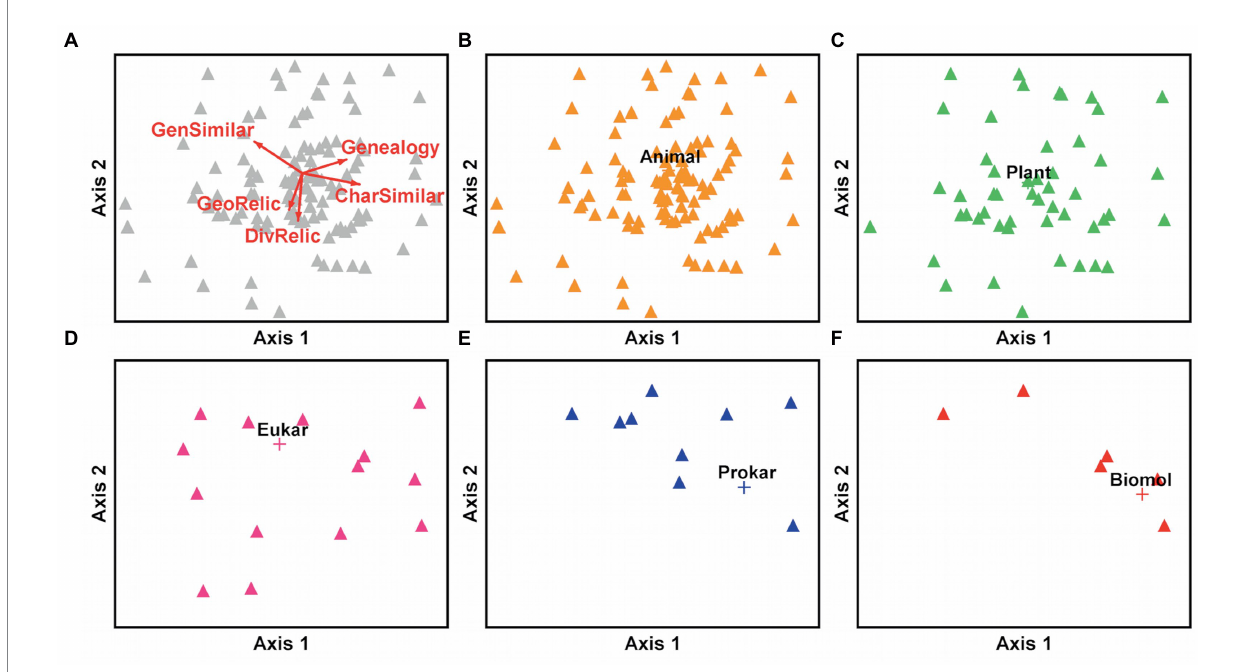
FIGURE 9 NMS ordination space derived from 1,402 original entities and 8 living fossil criteria, excluding the criterion ‘other.’ (A) Locations of all entities (grey) shown projected on NMS axes 1 and 2. Note that each point may represent one or many entity occurrences. Red vectors indicate significant influence and direction of the most important individual criteria on the two axes: GenSimilar = general ancestral similarity; CharSimilar = character ancestral similarity; Genealogy = genealogical inference; DivRelic = diversity relic; GeoRelic = geographic relic. The subsequent panels show the locations of groups of entities in the same ordination space: (B) Animal = Animalia; (C) Plant = green plants; (D) Eukar = eukaryotes not including animals and plants; (E) Prokar = prokaryotes, Archaea and Bacteria; (F) Biomol = Biomolecules. Group names are shown directly above distance-weighted centroids (+) for all occurrences of entities in each group (including multiple occurrences that sometimes coincide in a single point on these